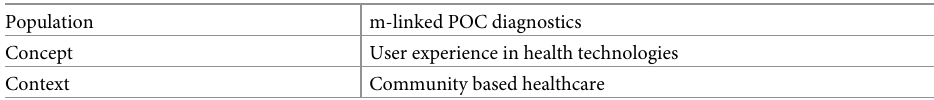
Table 1. PCC for determining the eligibility of the research